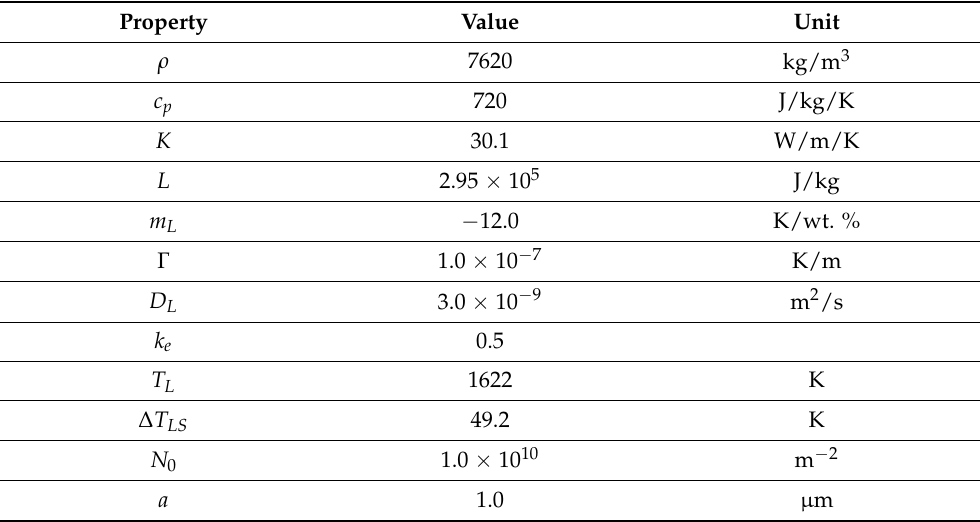
Table 1. Themo-physical and material kinetics properties of IN625 [4,10,18]. Property Value Unit ρ 7620 kg/m 3 720